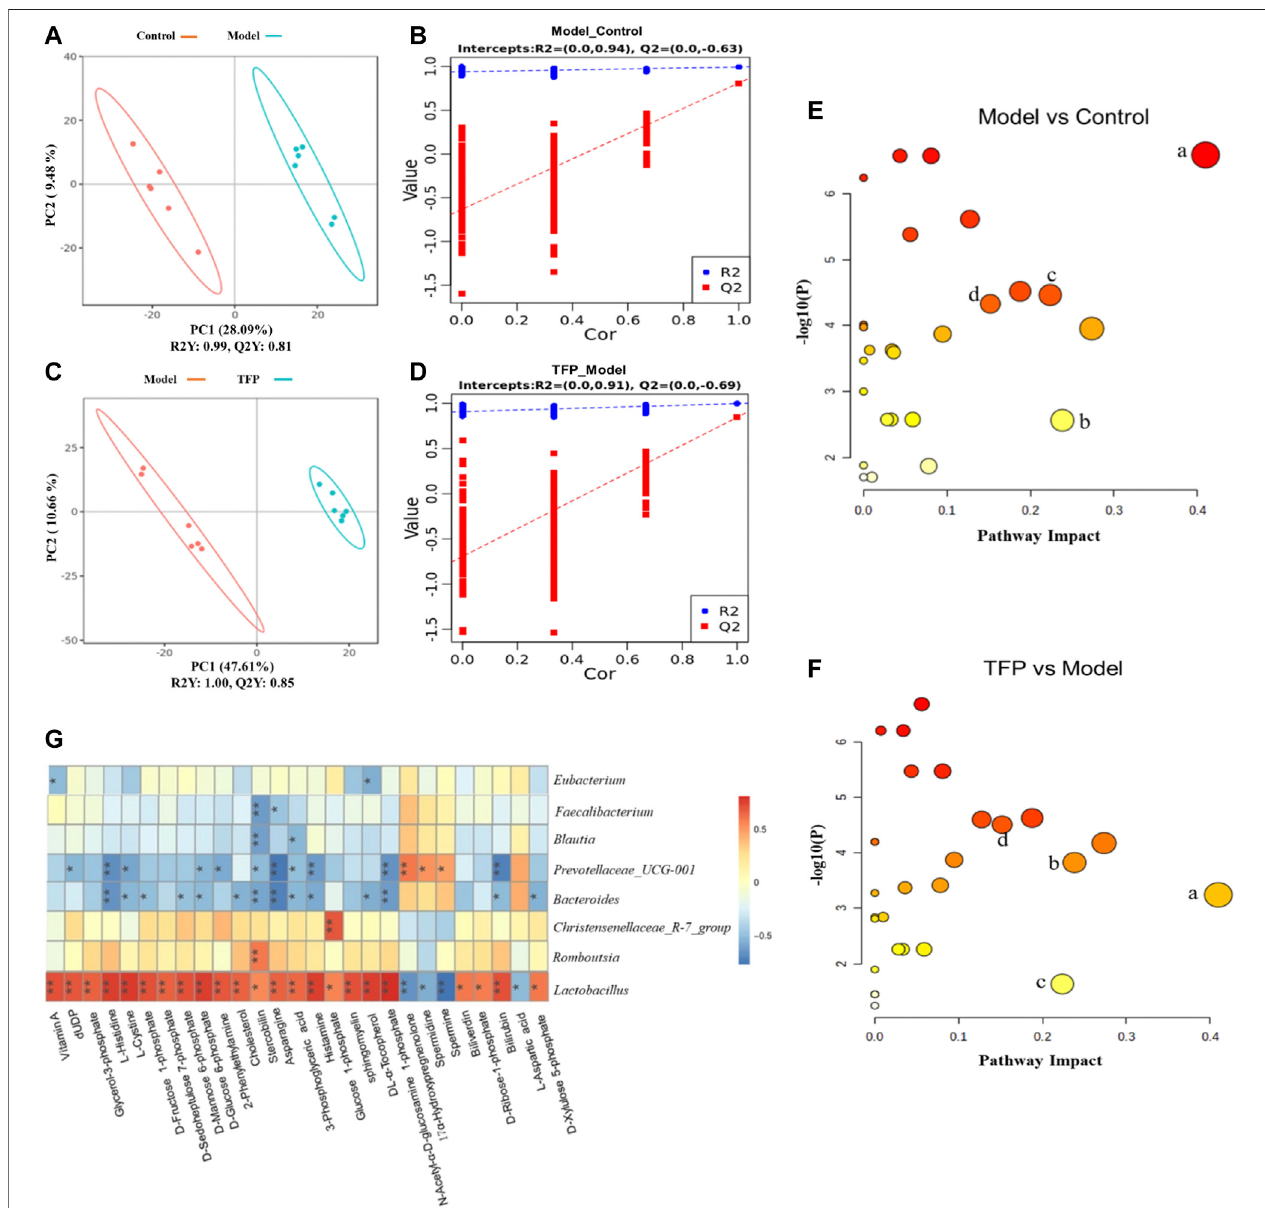
FIGURE4| TFPtherapyregulatedthemetabolitesinserumofCIAratsandthecorrelationswithgutmicrobiota. (A,C) :PCoAscoresofOPLS-DAbetweenControl/ Model groups and between Model/TFP groups. (B,D) : OPLS-DA loading coef fi cients between Control/Model groups and between Model/TFP groups. (E,F) : Analysis on pathways of the 27 differential metabolites. Commo pathways between those obtained from PICRUSt of 16S rRNA sequencing and those related to untargeted metabolomics( p < 0.05,Impact > 0.1)wereremarkedasa:Histidinemetabolism; b:Phenylalaninemetabolism;c:Alanine,aspartateandglutamatemetabolism;d: Aminosugarandnucleotidesugarmetabolism (G) :Spearman ’